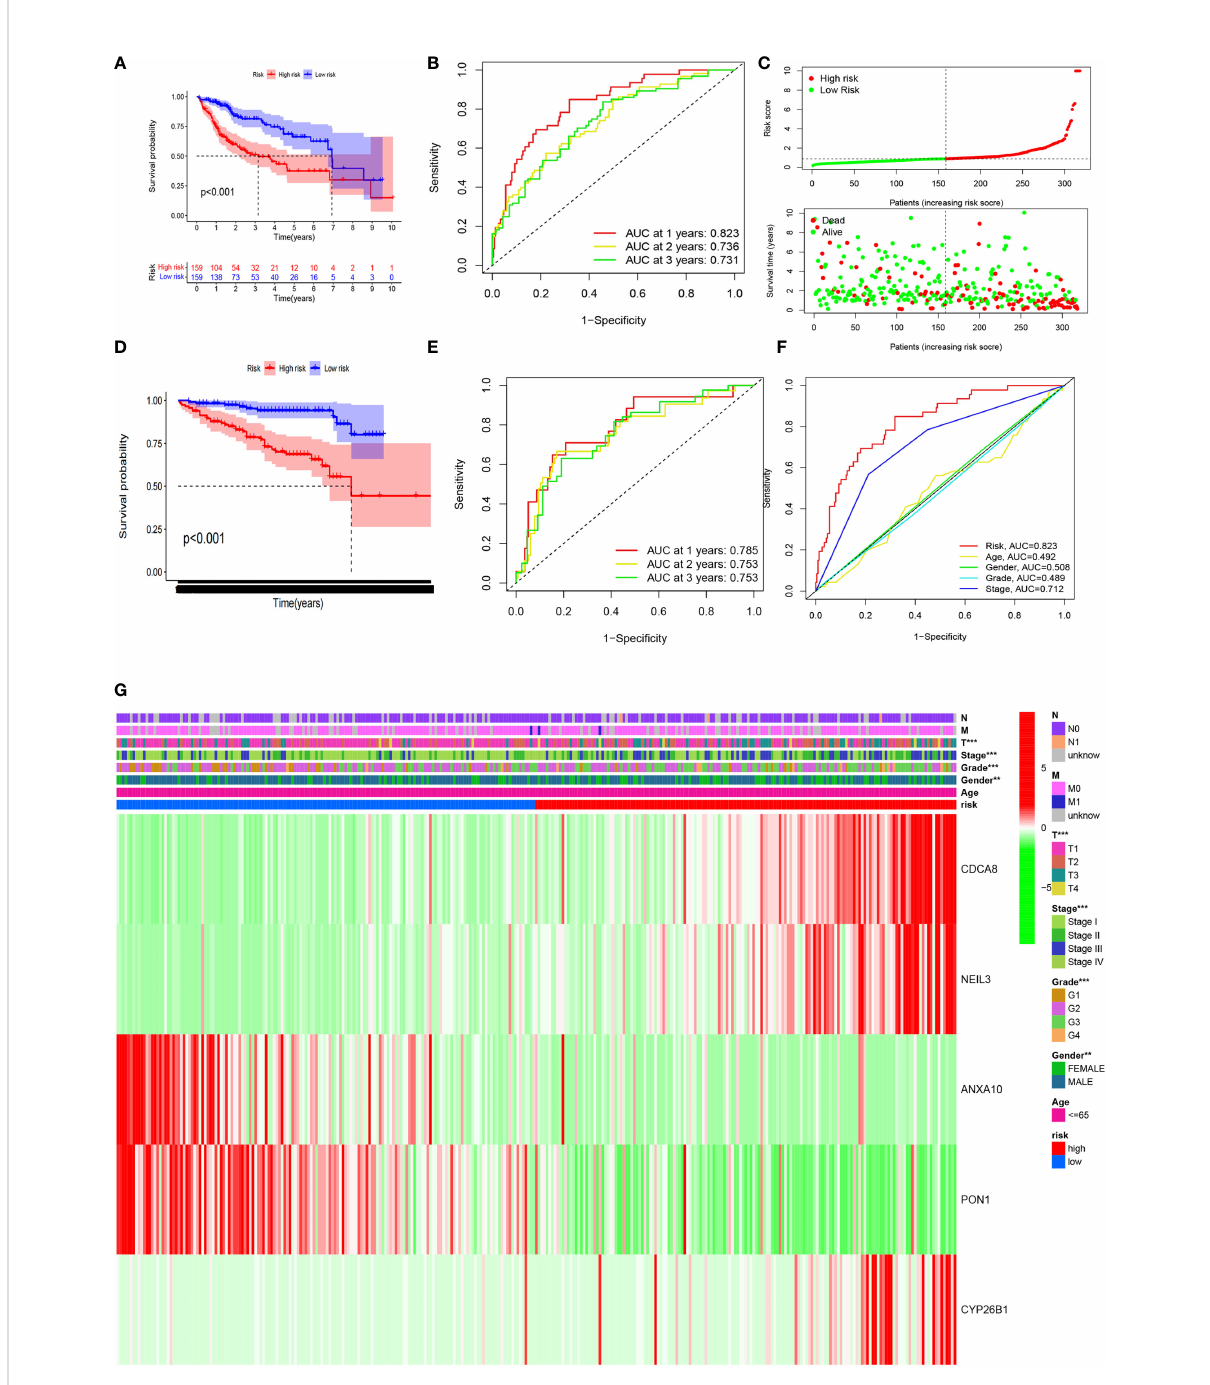
FIGURE 7 The CRsscore in the TCGA cohort. Kaplan – Meier curves (A) , time-dependent ROC analysis (B) , risk score (C) , and multi-index ROC analysis (F) . Thermograph of the clinicopathological features among risk subgroups (G) . The CRsscore was validated in the ICGC cohort. Kaplan – Meier curves (D) and time-dependent ROC analysis (E)